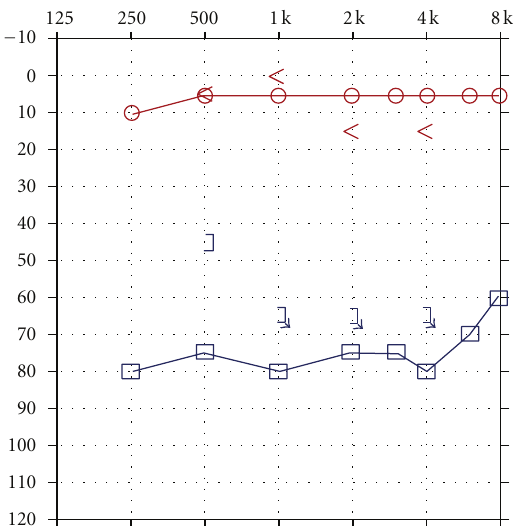
Figure 1: Audiogram depicting normal auditory sensitivity for the right ear and a hearing loss of severe degree and sensorineural origin for the left